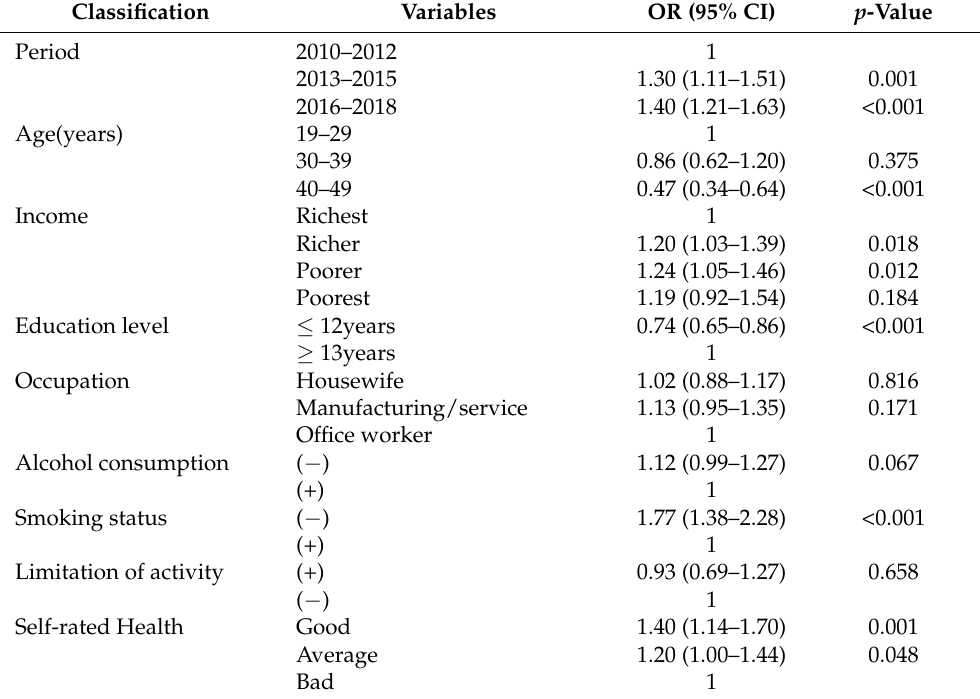
Abbreviations: OR, odds ratio; CI, confidence interval. Values were calculated by multivariable logistic regression analysis, which was adjusted for period, age, income, education level, occupation, alcohol consumption,